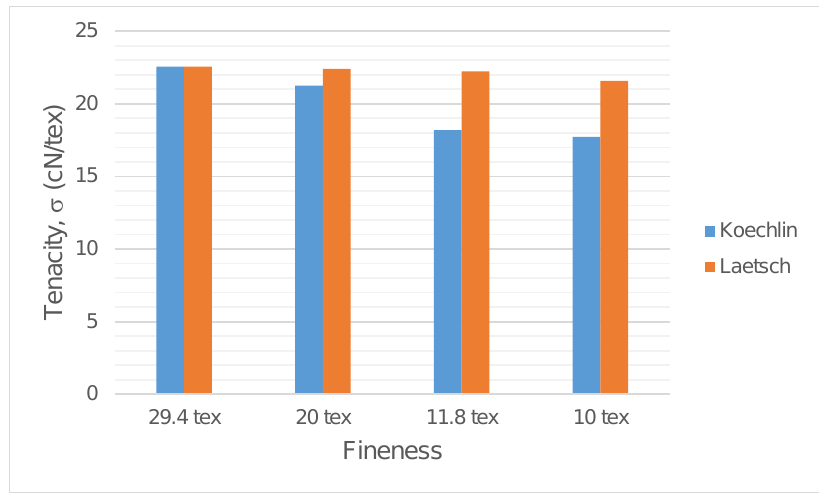
Figure 7. Tenacity as a function of the number of turns per meter and fineness of yarn.